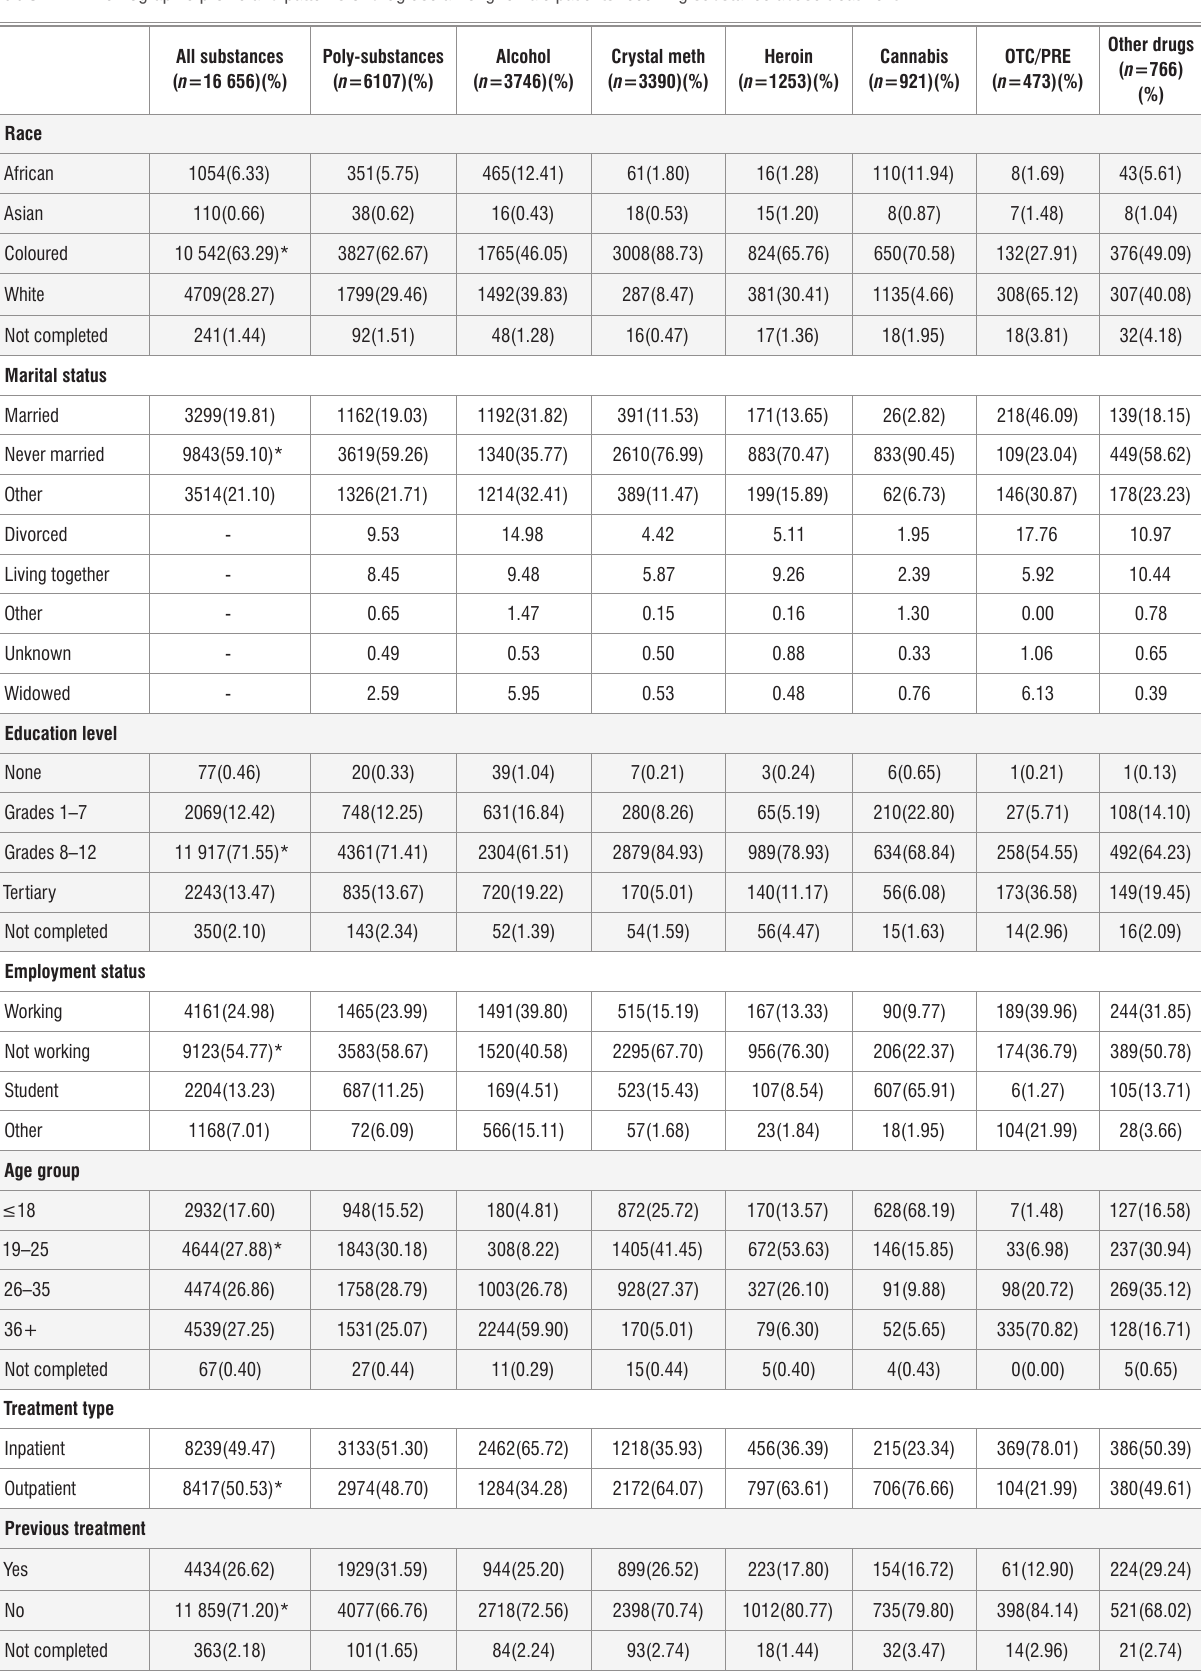
Table 1: Demographic profile and patterns of drug use among female patients receiving substance abuse treatment All substances ( n =16